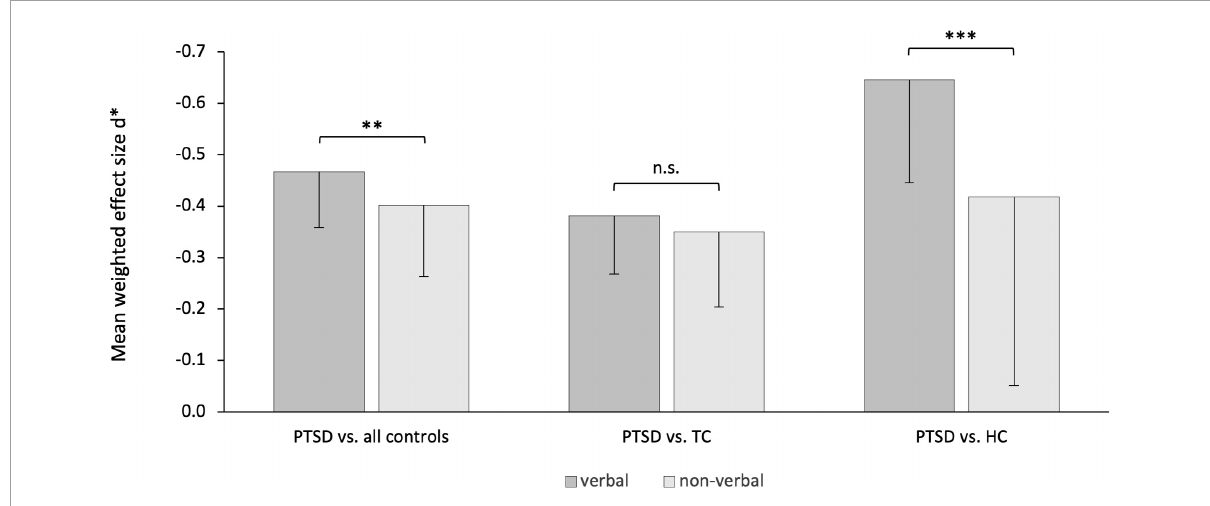
FIGURE4 Effect of stimulus material separated by analysis groups. Stronger impairments of episodic memory of post-traumatic stress disorder patients in verbal than non-verbal memory tests. The effect was statistically significant for the comparison with all controls (left) and in sub-comparison with healthy controls (HC, right ) but not compared to trauma control group (TC, middle ). n.s. abbreviates not significant. ∗∗ p < 0.001, ∗∗∗ p <